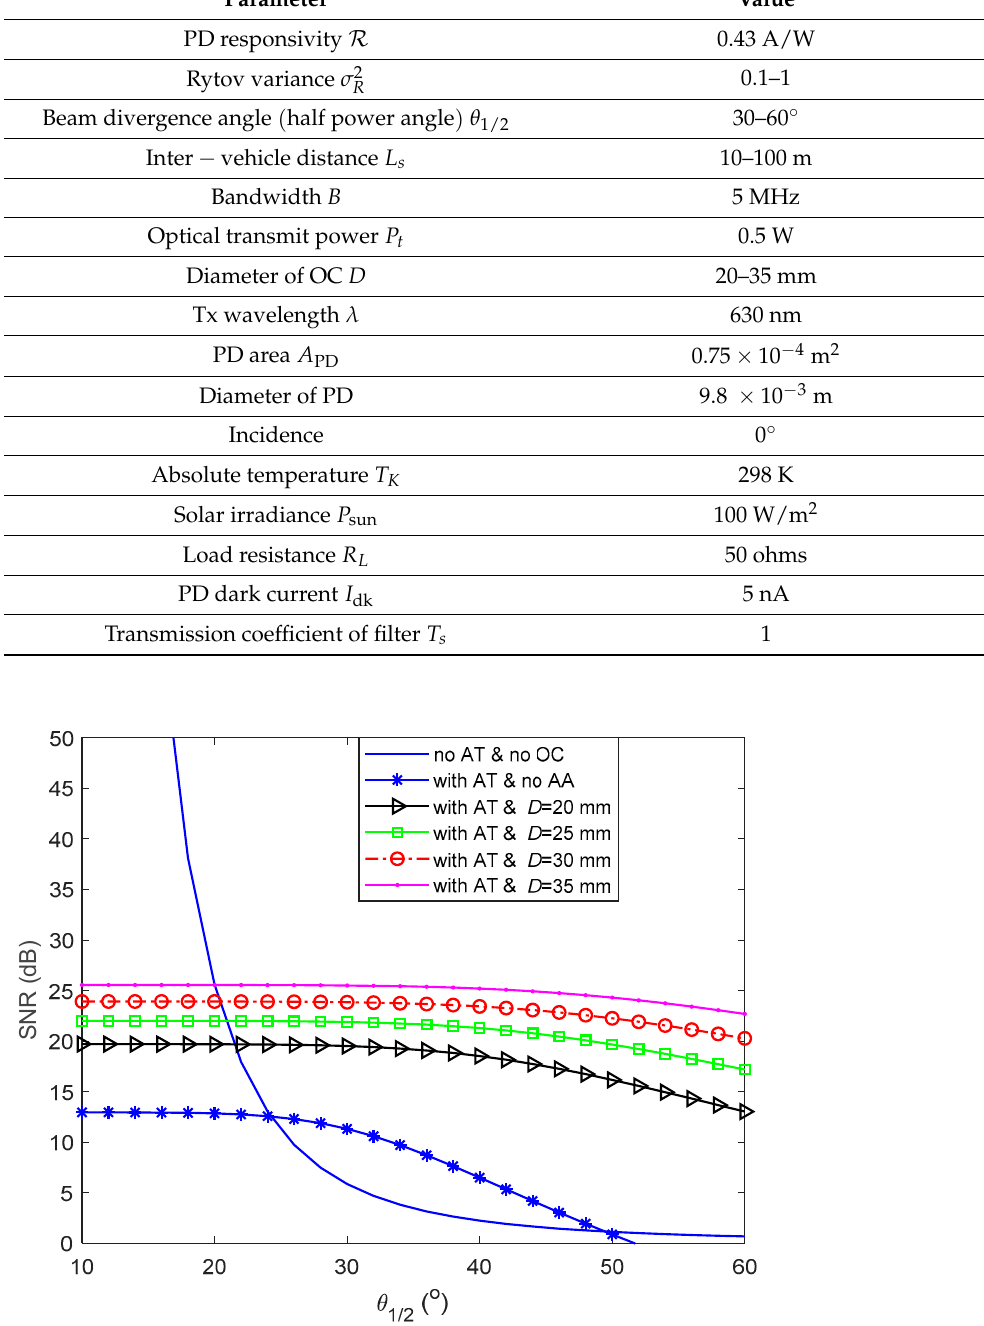
Table 1. Key simulation parameters.